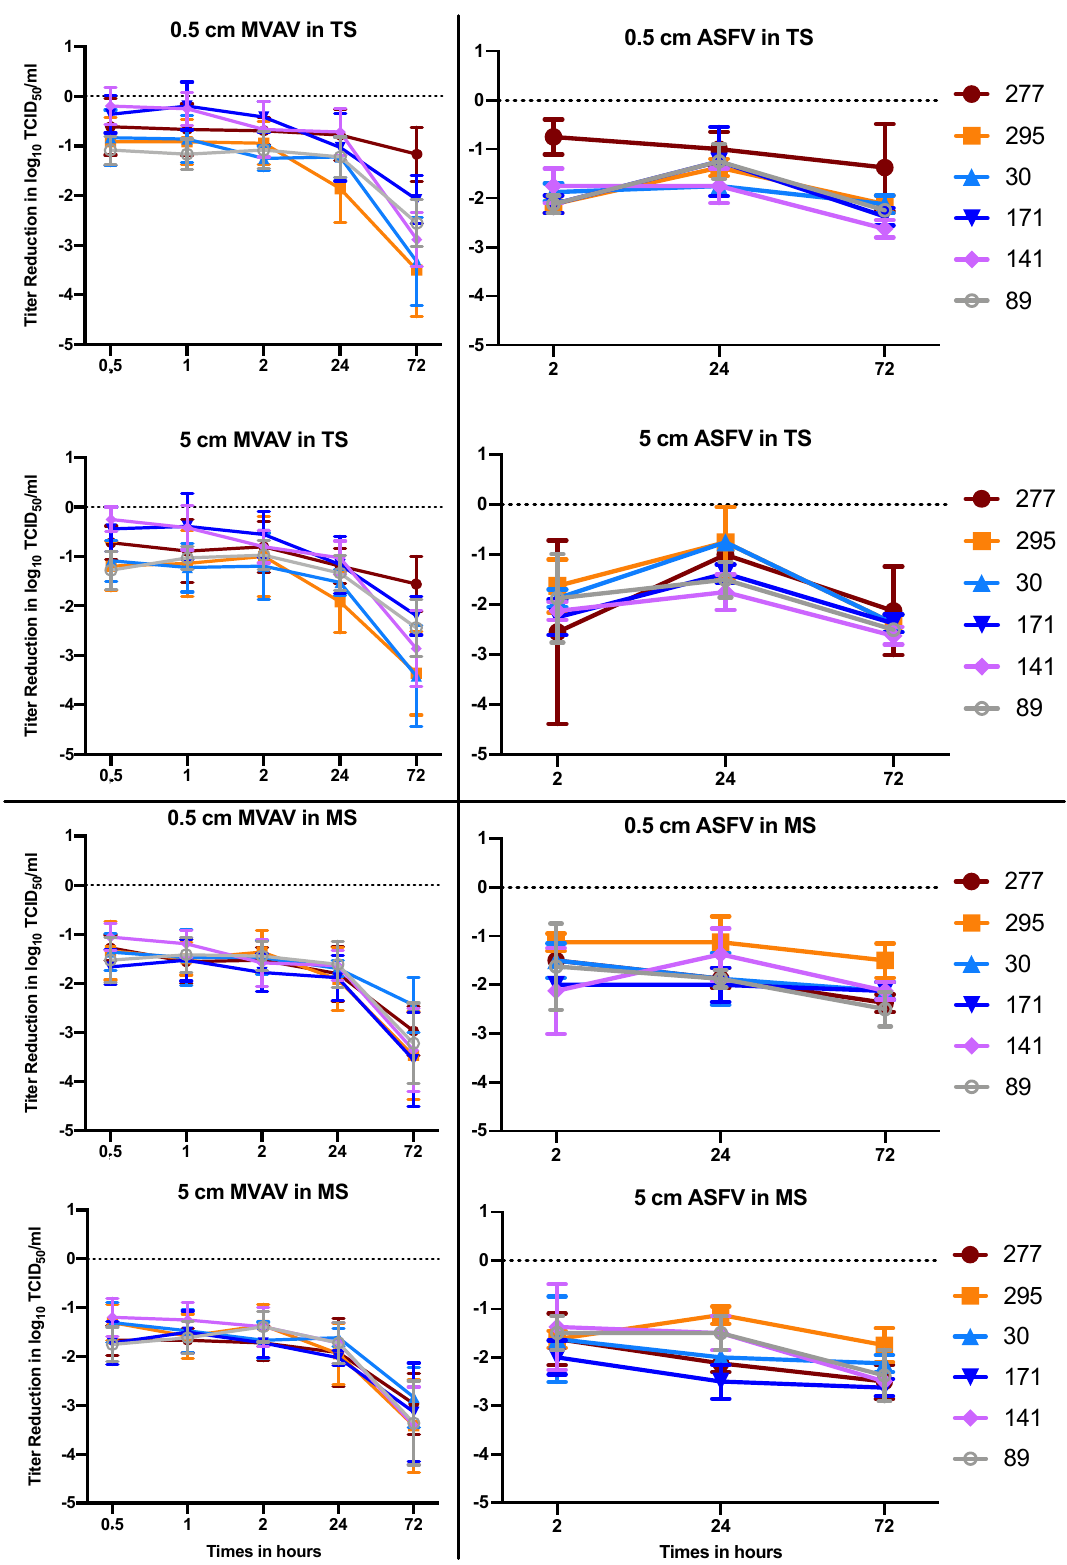
Figure 1. Comparison of the tenacity of MVA ( left ) and ASFV ( right ). Top 4 panels are topsoil (TS) and lower 4 panels are mineral soil (MS). The mean value and standard deviation of at least double measurements are shown for each test point.